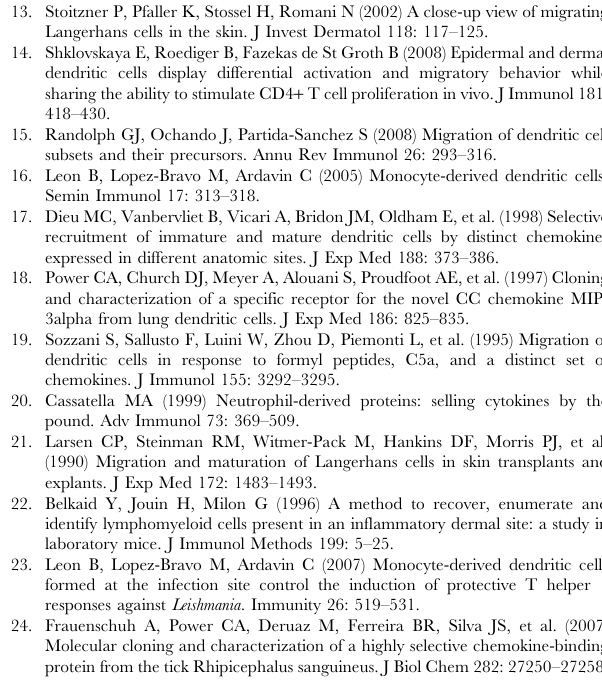
Figure S2 DC recruitment resulting from L. major versus needle injury. The number of neutrophils, Langerhans/dermal DCs, and monocyte-derived DCs emigrating from ear explants was measured at 0, 6, 24 and 48 hours post L. major inoculation (solid lines), or post injection of a similar volume of DMEM medium (dotted lines) *: p , 0.05 comparing cell number in C57BL/6 versus BALB/c mice. Values from ear explants are expressed as mean values 6 SEM (n=